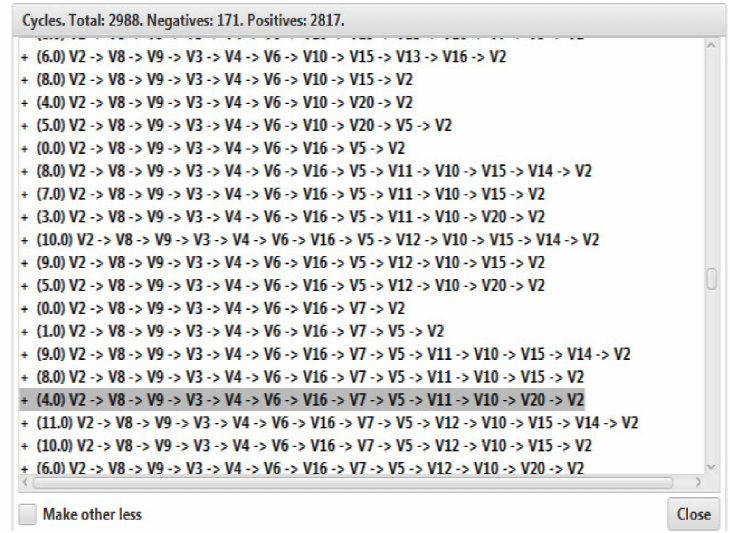
Figure 2. “Positive” cycle selection of the regional system relationship (fragment from the computer data processing results on the program CMSS).